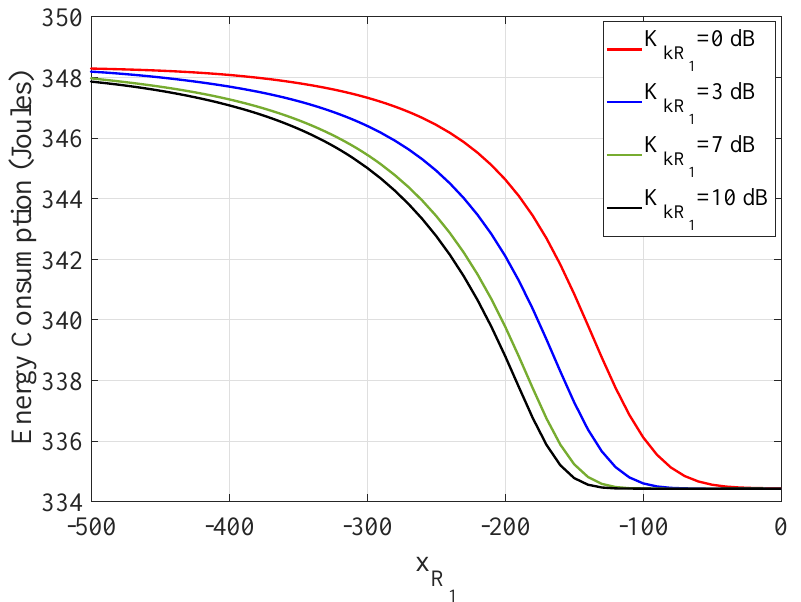
Figure 8. The WTEC as a function of the location of the RIS units along the x-axis for different values of the Rician factor K kR . 1